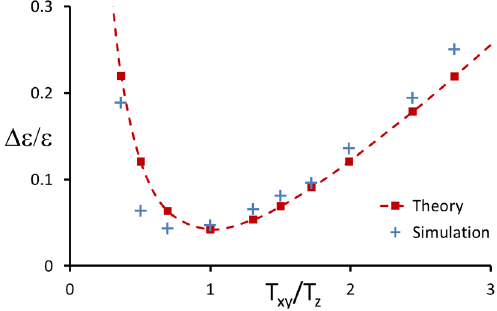
FIG. 8. Δ ϵ 6 d = ϵ 6 d for k 0 xyz ¼ 60 = 60 = 47 ° and varying (initial) temperature anisotropy.